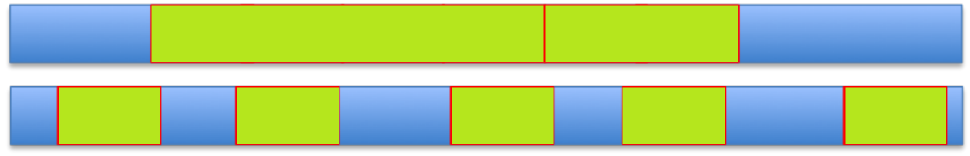
Figure 3. Similar frame-wise accuracy may have large qualitative differences. The top row generates neighbouring segments. The bottom row generates the same proportion of segments but they are non-contiguous, leading to numerous over-segmentation